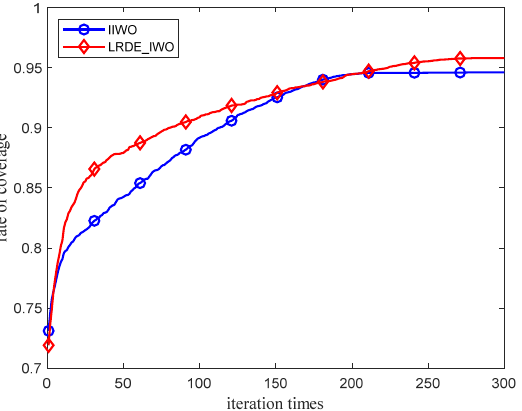
Figure 10. Coverage optimization iterative curve of IIWO and LRDE_IWO.